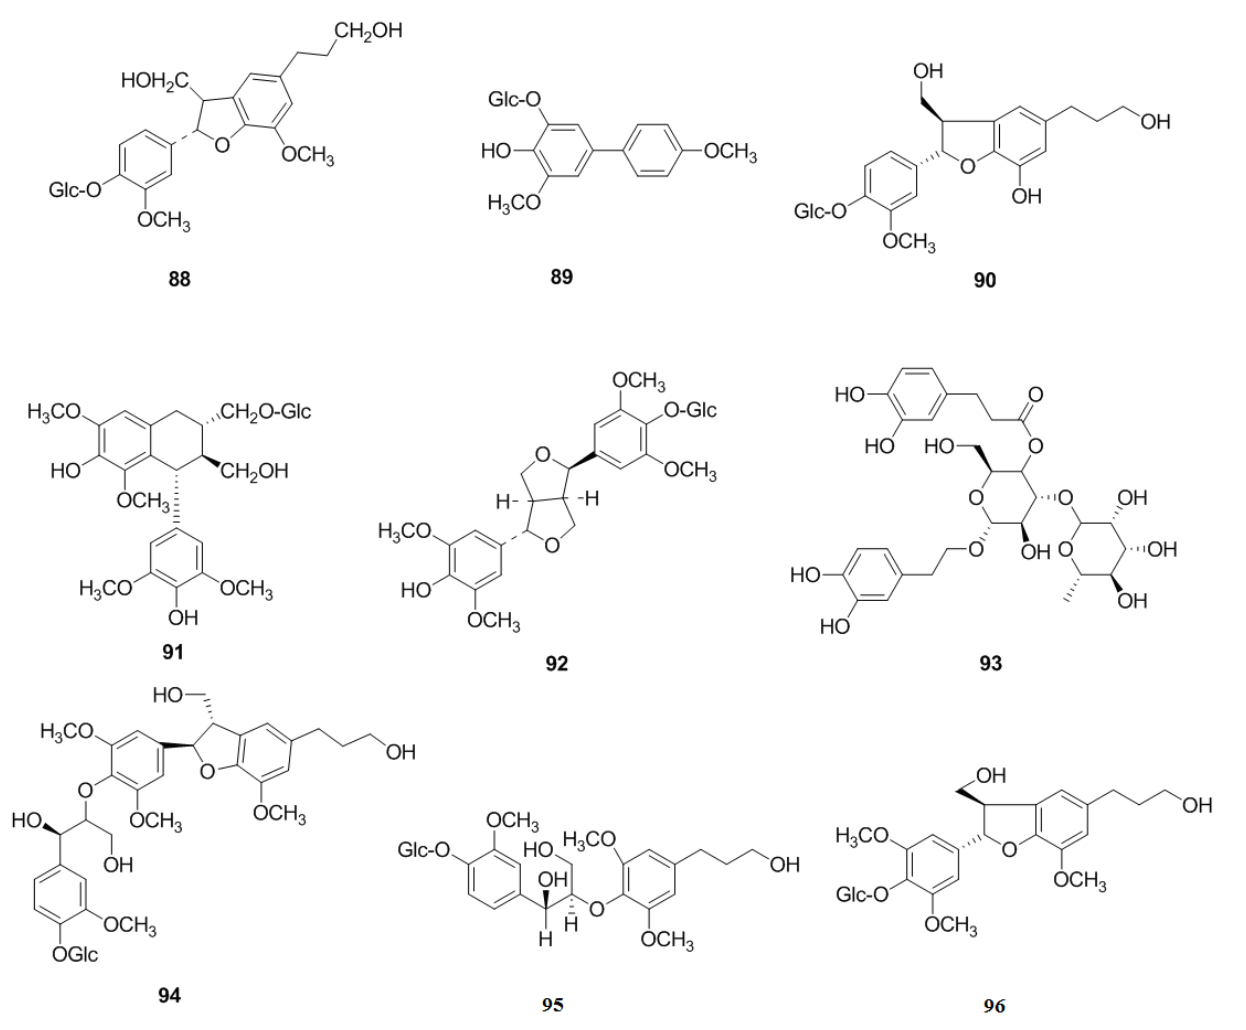
Figure 8. Chemical structures of lignans in C. pinnatifida